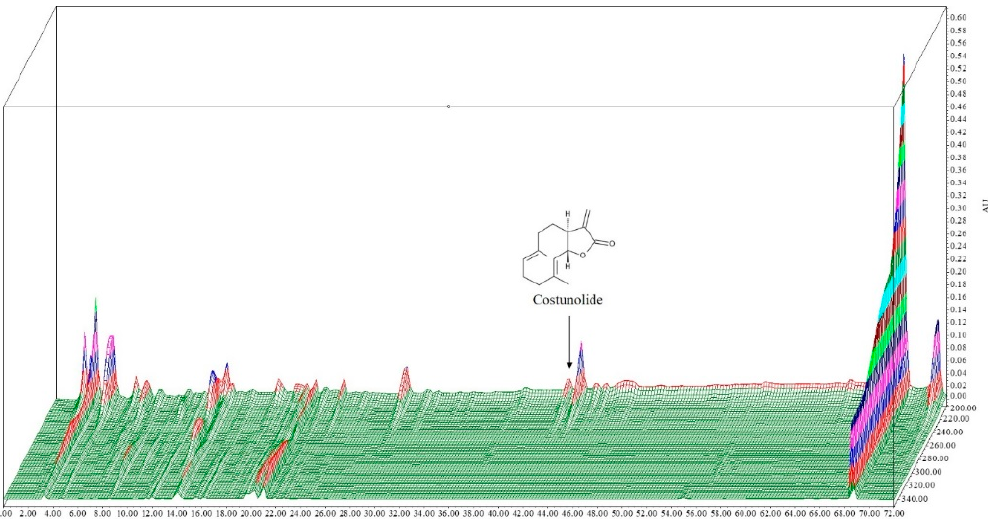
Figure 1. 3-D HPLC chromatogram of Aucklandia lappa extract. X: retention time; Y: wavelength, and Z: absorbance unit.